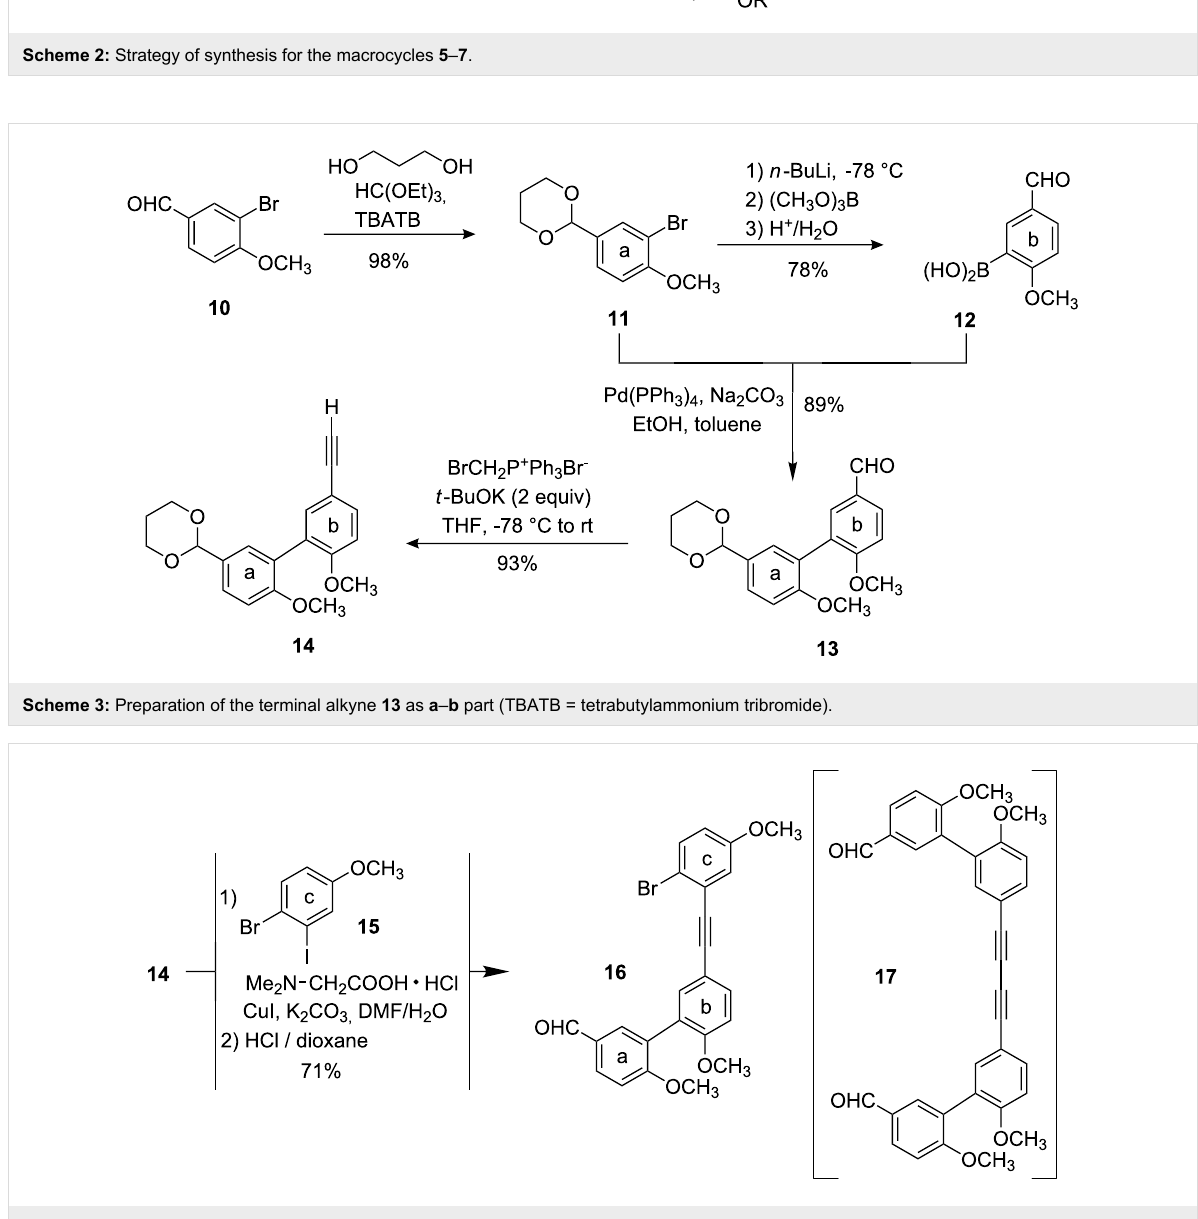
Scheme 4: Sonogashira-type coupling to the tolane 16